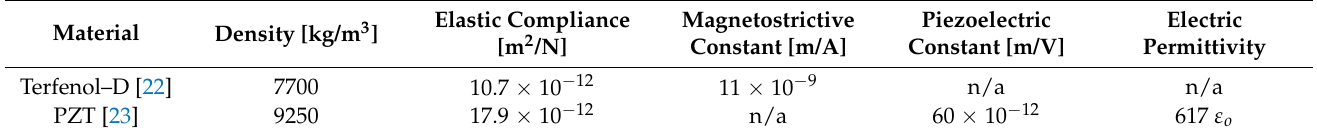
Table 1. The properties of PZT and Terfenol–D.